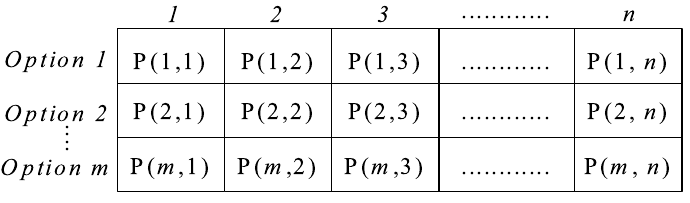
Figure 2. Probability matrix [ P ]